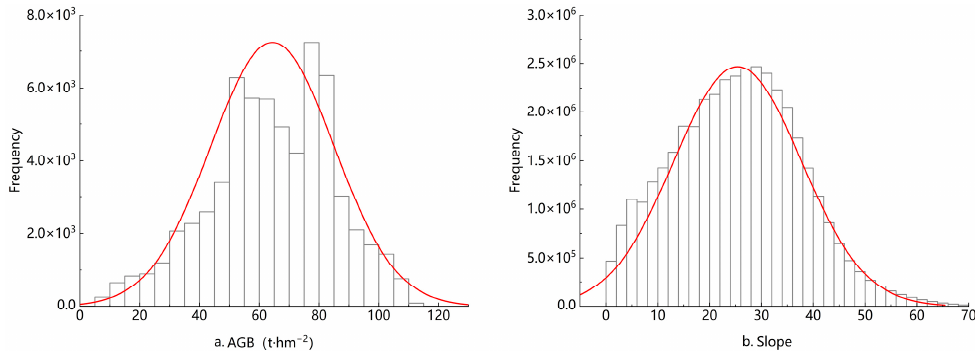
Table 5. Statistical characteristics of AGB and covariable.